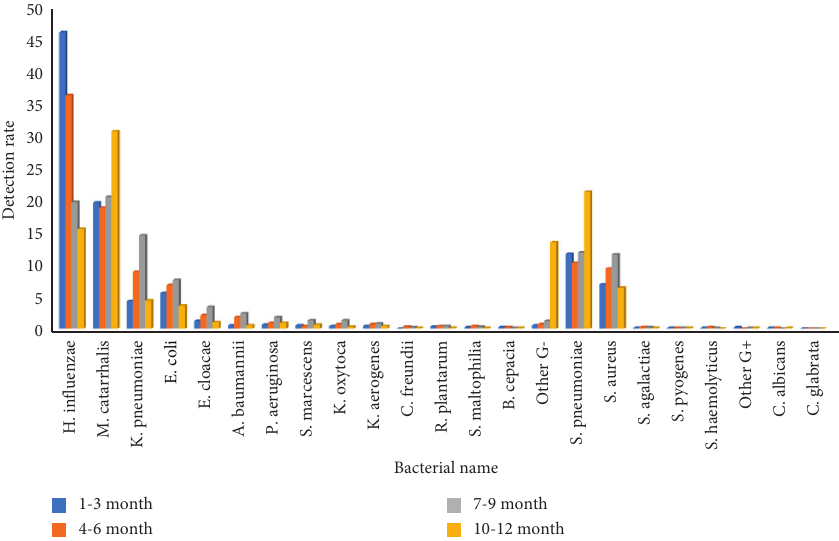
Figure 6: Detection rate of pathogens in lower respiratory tract in different seasons from 2018 to 2020 (%).